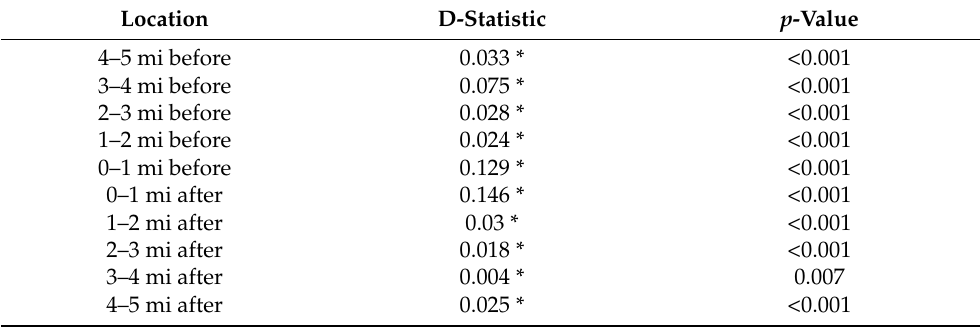
Table 1. Kolmogorov–Smirnov test showing the distributions during the presence and absence of enforcement.